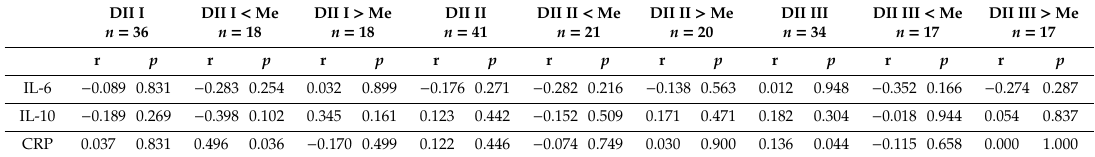
DII: dietary inflammatory index; CRP: C-reactive